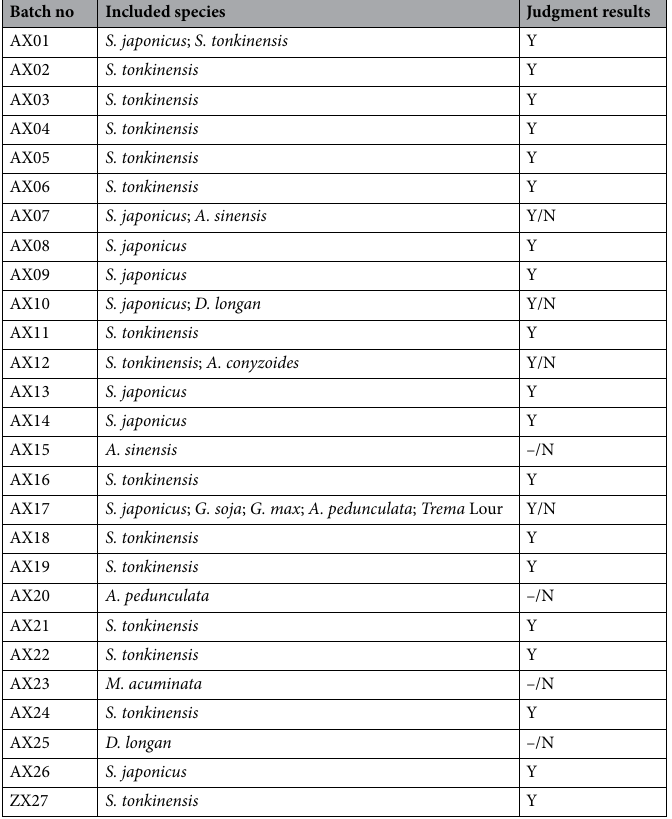
Batch no Included